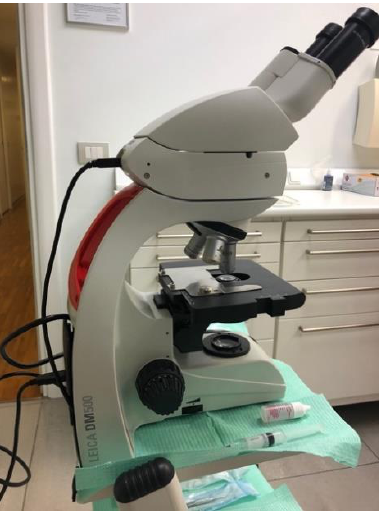
Figure 8. C ontrast-phase microscope in periodontal office. Figure 8. Contrast-phase microscope in periodontal